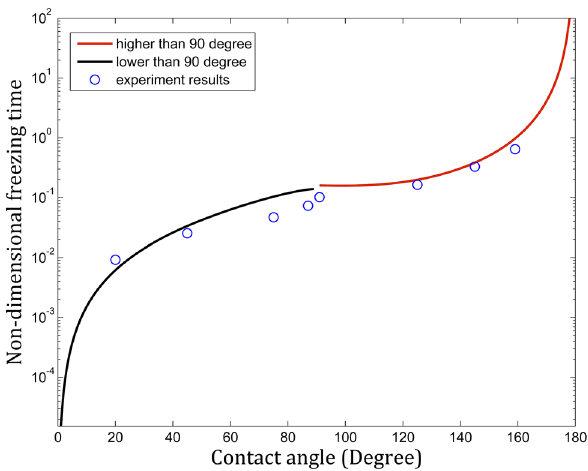
Figure 5. Theoretical calculation of the non-dimensional freezing time and the experiment results.